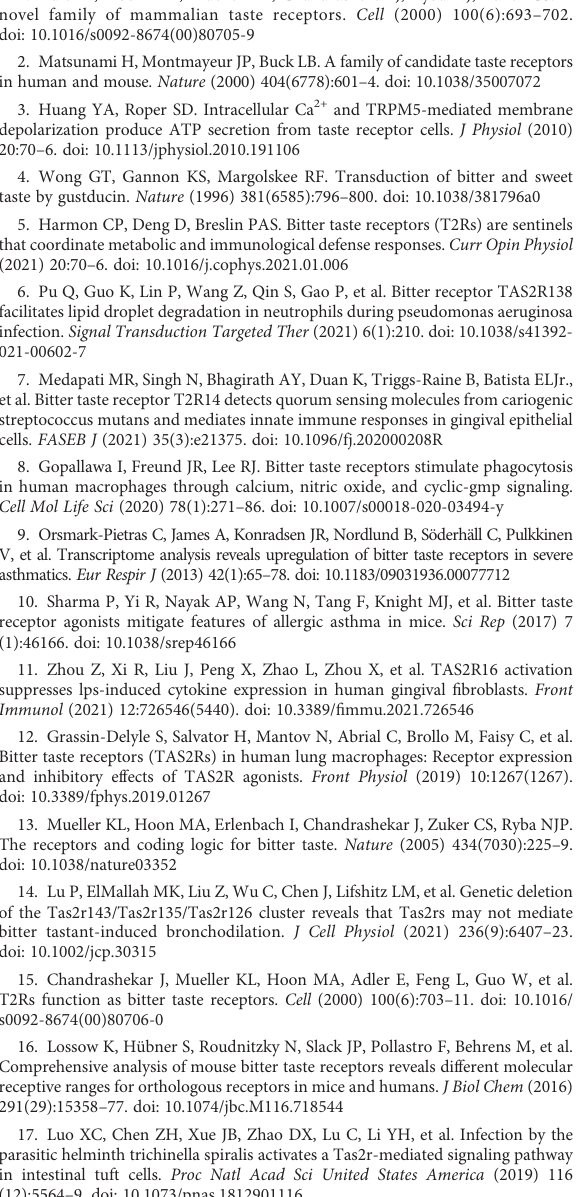
or 2 m g zymosan with 25 mg arbutin, and in fi ltered neutrophils were enumerated 6 h later by FACS analysis. Data represent the mean ±SEM of SUPPLEMENTARY TABLE 1 List of gRNA on-target sequences and PCR primer sequences. SUPPLEMENTARY DATA SET 1 Analysis of 36 mouse Tas2r gene expression levels in immune cells by ImmGen RNA-seq